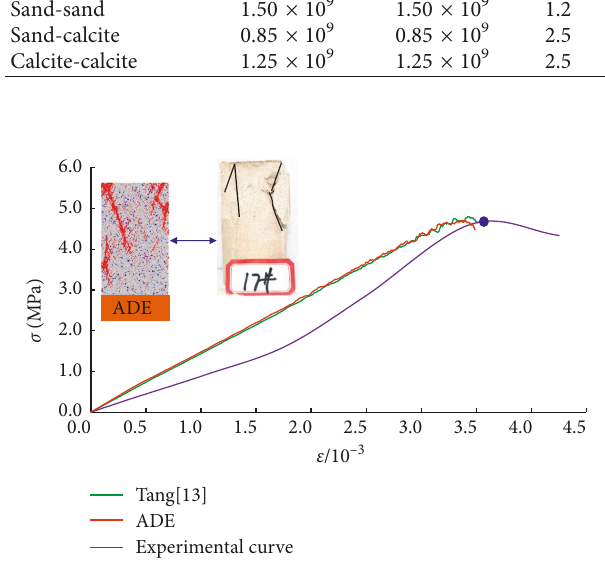
Figure 10: Comparison of numerical simulation and experimental stress-strain curves and failure